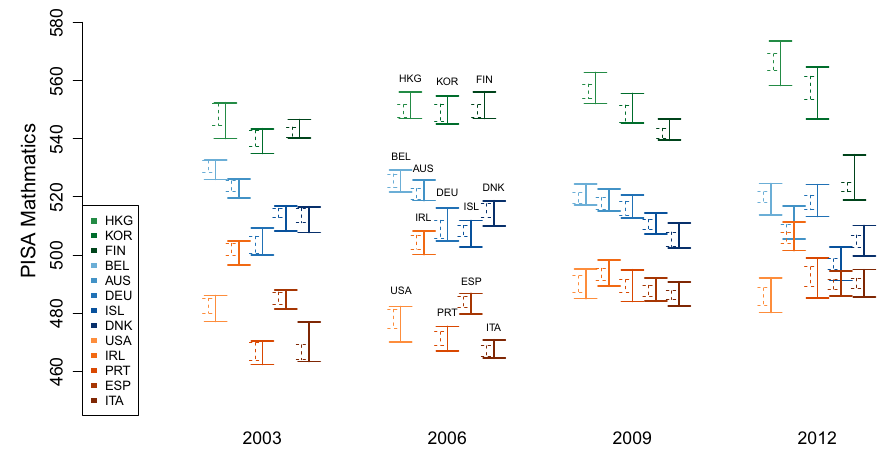
a Variance components considering 40 countries.